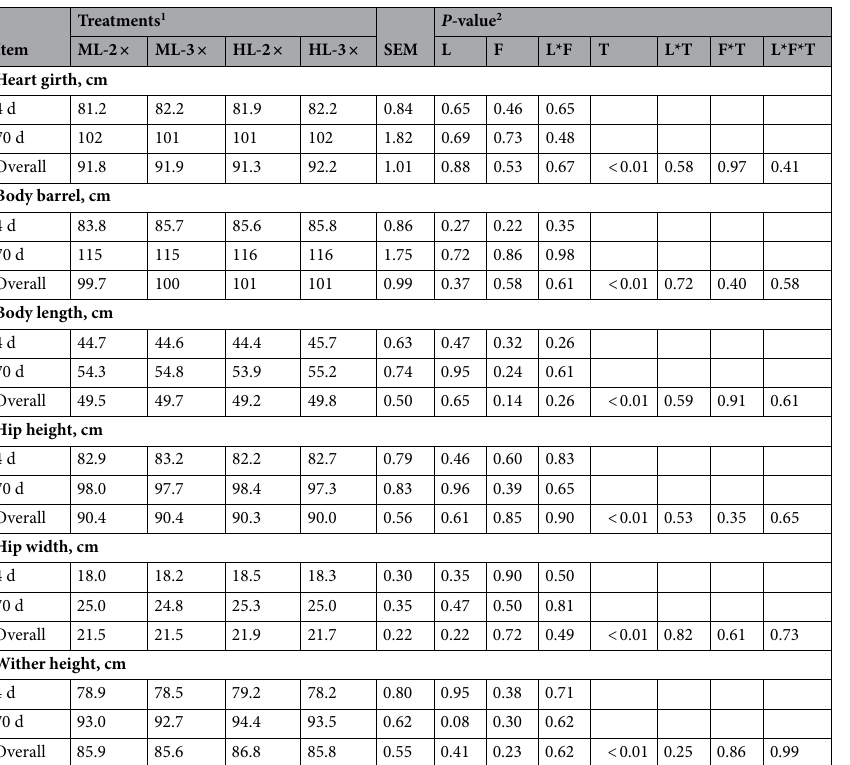
Table 3. Effects of milk feeding level (medium vs. high) and milk feeding frequency (2 vs. 3) on skeletal growth of dairy calves during days of 4, 70, and overall (n = 12 calves/treatment). 1 Treatments including level; F = feeding frequency, L × F = feeding level × feeding frequency, T = time, L × T = feeding level × time, F × T = feeding frequency × time, and L × F × T = feeding level × feeding frequency ×